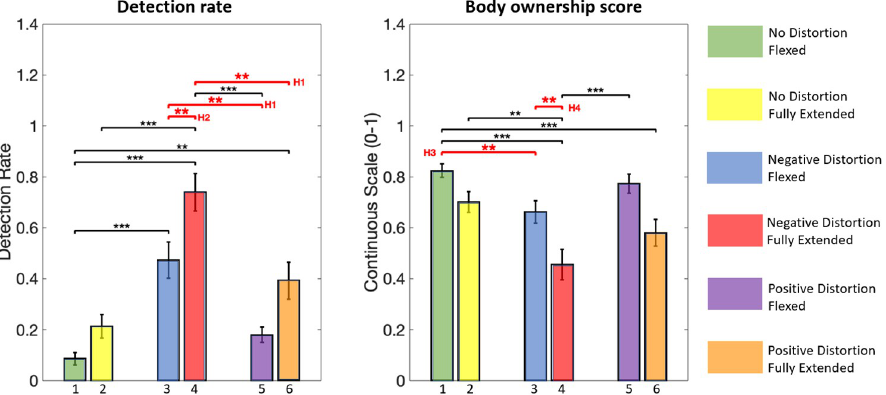
Fig 5. Results for each experimental case (as numbered in Fig 3 with their respective color). The detection rate was defined as the percentage of “No” for each condition to evaluate the impact of the articular limits on the detection threshold. Error bars represent the standard error of the mean. �� p < 0.01, ��� p < 0.001.